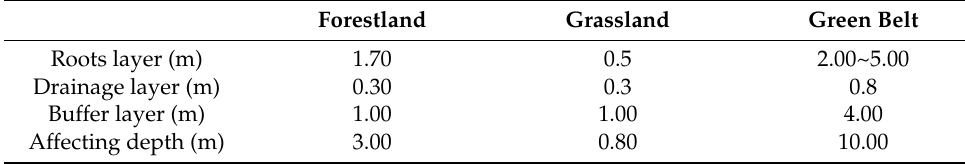
Table 7. Affecting the depth of urban green